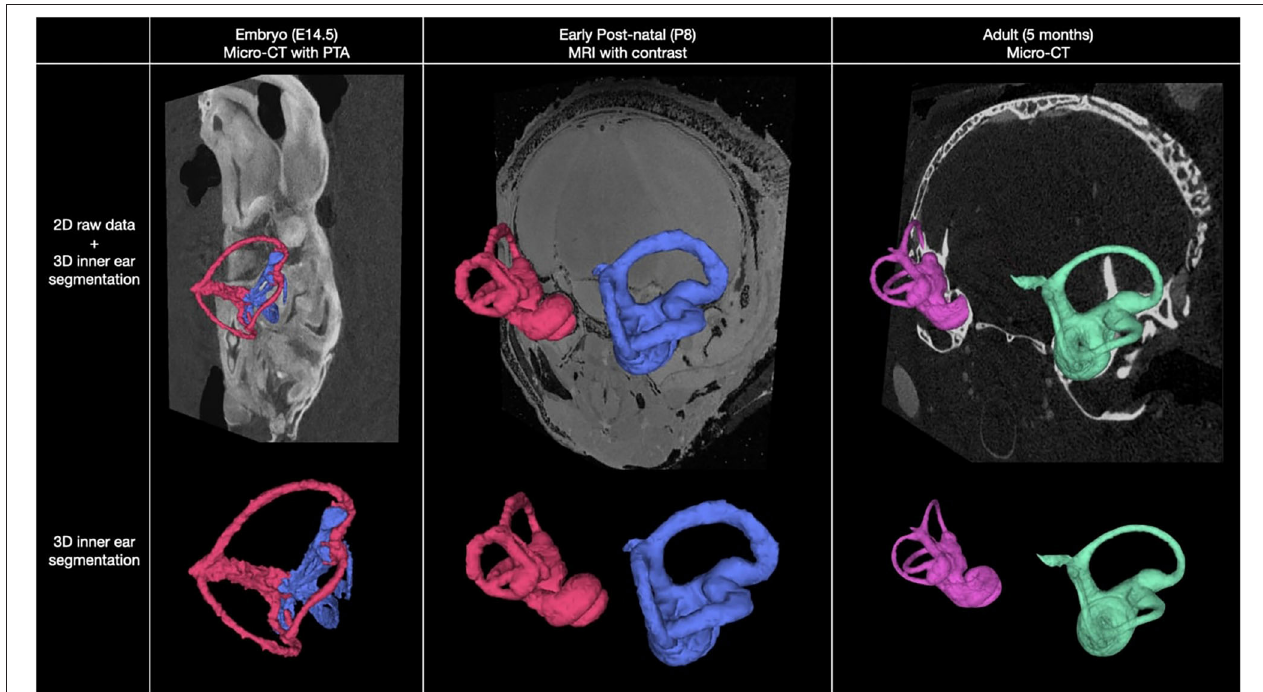
FIGURE 1 | Overview of murine inner ear anatomy at three stages of development. Multimodal, 2D coronal images overlayed with 3D segmentation of the inner ear at embryo, post-natal, and adult stages (top row). Isolated 3D segmentations of the inner ear at each stage of development are shown (bottom